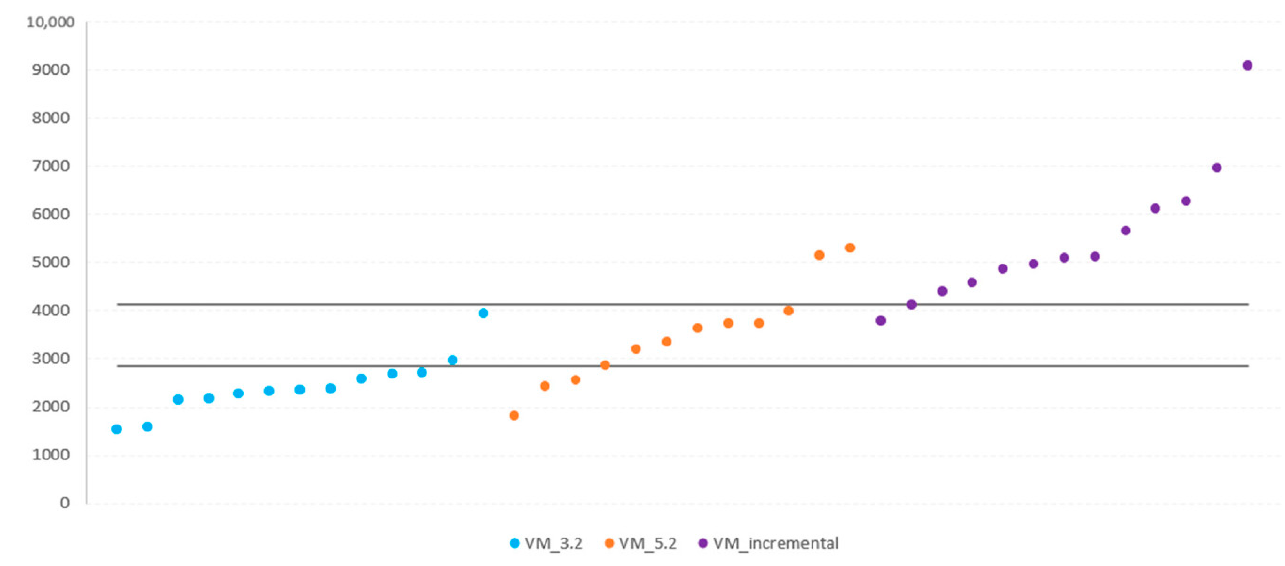
Figure 1. Vector Magnitude across the speed of 3.2 km/h, 5.2 km/h, and incremental test.